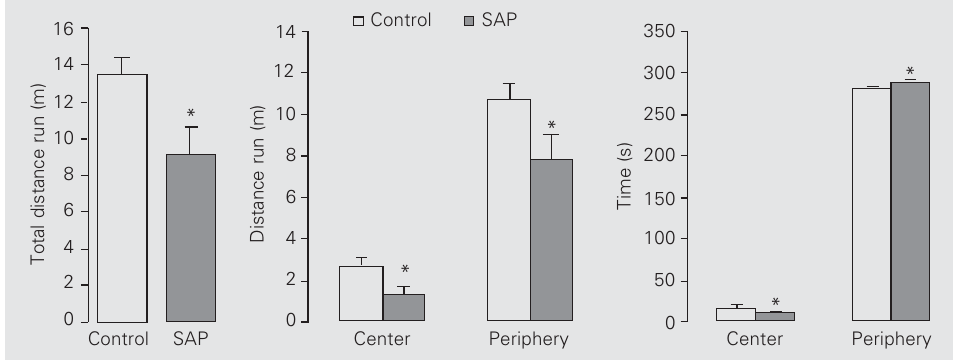
Figure 1. Effect of intraseptal le- sion of the cholinergic compo- nent of the rat septohippocam- pal system. The figure reports total distance and distance run in the center and periphery (mean ± SEM) of an